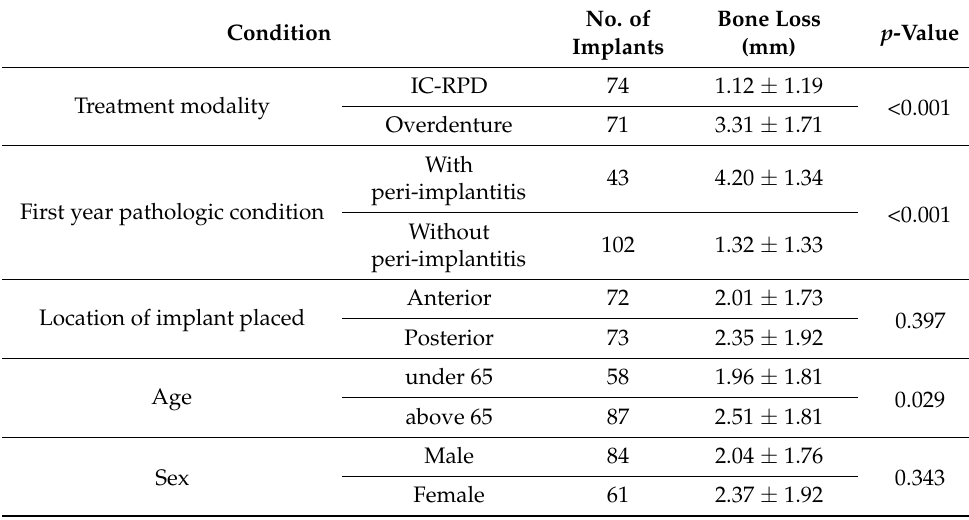
Figure 5. Marginal bone loss change through time according to treatment modality. The red asterisks indicate significant differences between IC-RPD and IOD groups ( p < 0.0125; adjusted by Bonferroni’s method). Average time of final check-up (i.e., observation end date) was different for IC-RPD (32.3 months) and IOD (63.4 months) groups. Asterisks indicated p < 0.001. Table 6. MBL of implants in IC-RPD and IOD according to